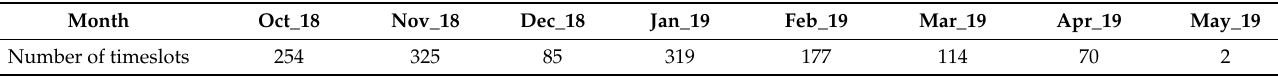
Table 7. Number of timeslots/month with high HVAC consumption.